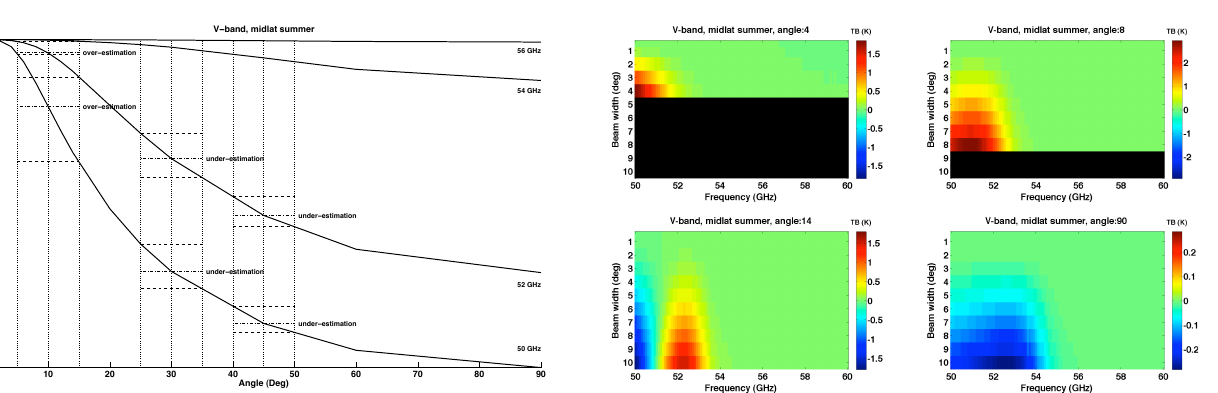
Fig. 14. The errors associated to the antenna beam width effect in Figure 14. The errors associated to the antenna beam width effect in differential TB for V-5 differential TB for V-band frequencies using the mid-latitude sum- band frequencies using the mid-latitude summer atmospheric profile. The TB differences are 6 mer atmospheric profile. The TB differences are defined as the TB defined as the TB calculated from a forward model without beam width minus the TB 7 calculated from a forward model without beam width minus the TB calculated from a forward model with beam width. Black area at calculated from a forward model with beam width. Black area at elevations 4° and 8° are 8 elevations 4 ◦ and 8 ◦ are when the beam at least partially hits the when the beam at least partially hits the ground. 9